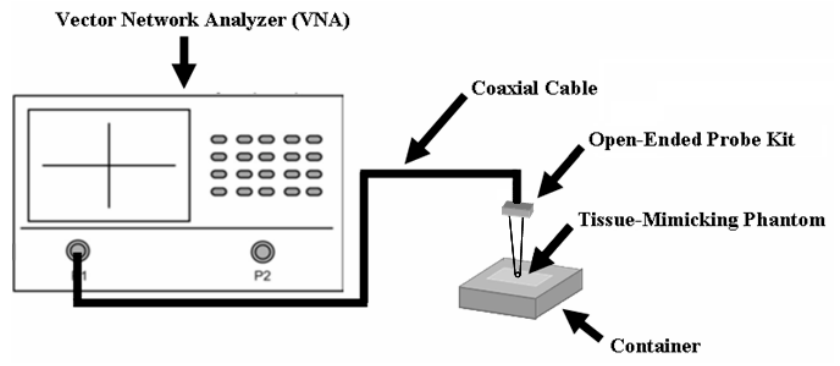
Figure 4. Schematic structure of the experimental setup for the measurement of dielectric properties.